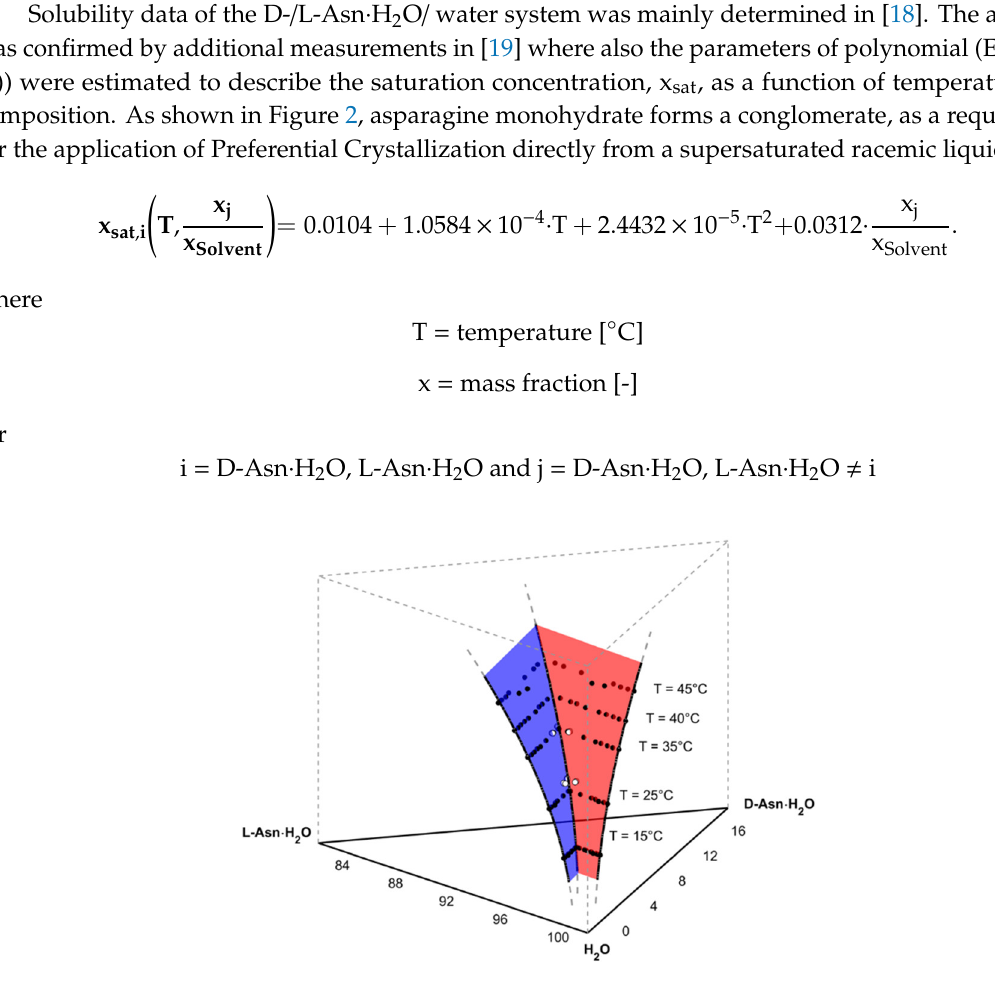
Figure 2. Upper 20% section of the ternary phase prism of the asparagine monohydrate enantiomers in water at different temperatures. All axes are given in mass fractions × 100 (wt%). Black and white dots—solubility data from [18] and [19], respectively. Red and blue surface—fitted solubility surface of D-Asn · H 2 O and L-Asn · H 2 O, respectively. Reprinted with permission from [19]. Copyright 2020 American Chemical Society.